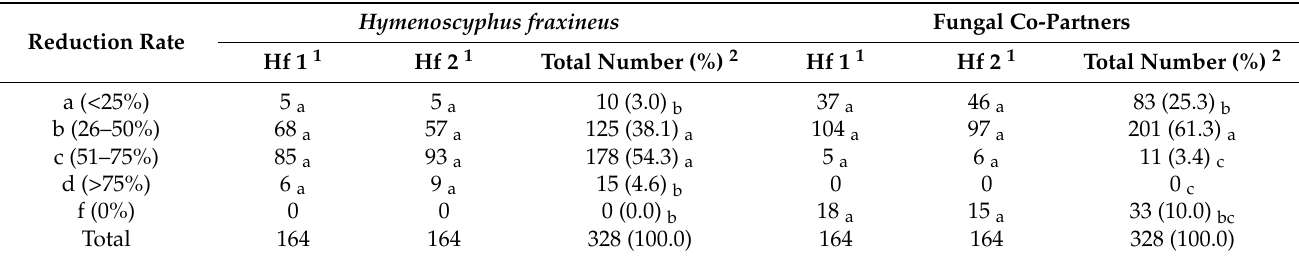
Table 5. Reduction in H. fraxineus and the test fungi colonies in dual